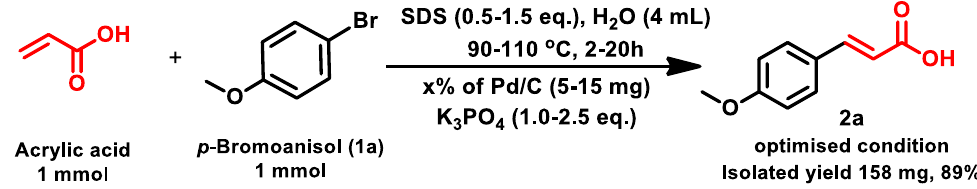
Figure 7. Pd/C-catalyzed MH-C reaction of p -bromoanisol (1a) and acrylic acid.